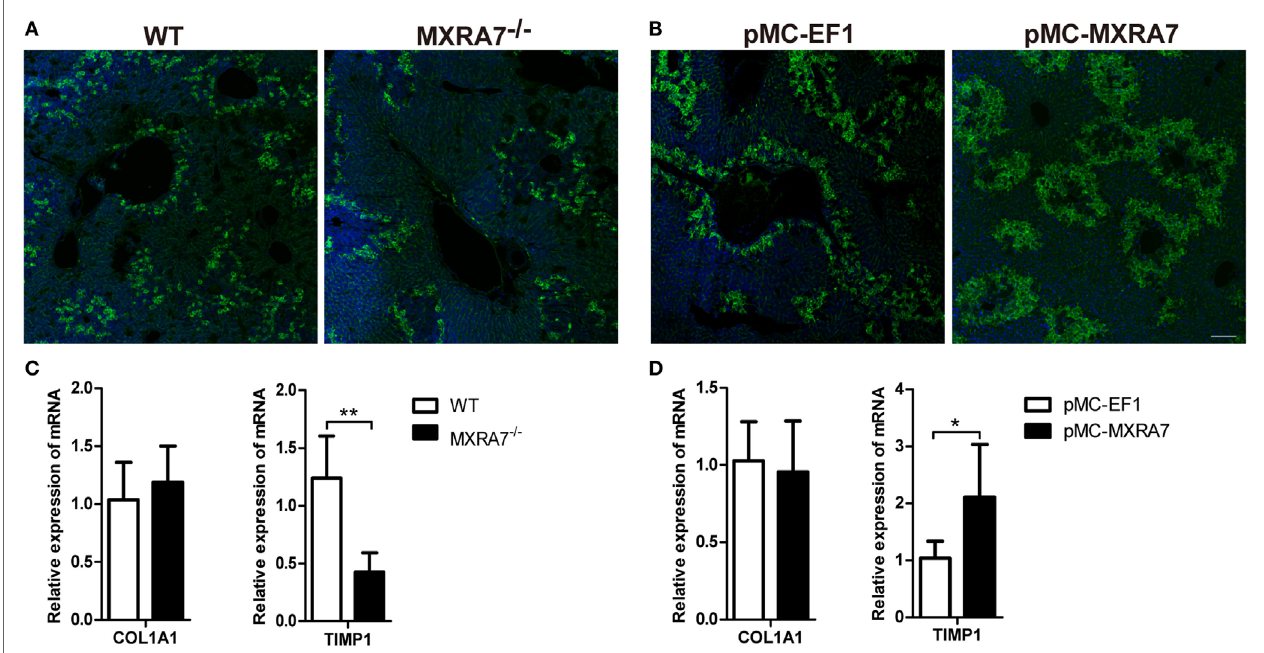
FigUre 6 | Matrix remodeling associated 7(MXRA7) deficiency inhibits and MXRA7 overexpression promotes the expression of fibronectin and TIMP1. Livers were isolated from different groups of mice 24 h after 1 ml/kg CCl 4 injection. (a,B) Expression of fibronectin (in green) in livers was detected using immunofluorescence analysis. Representative images from different groups are shown. Scale bar = 100 μ m. (c,D) Expression of COL1A1 and TIMP1 mRNAs in livers was detected by reverse transcription-quantitative real-time PCR. Data are presented as the summary of two experiments. * p < 0.05, ** p <